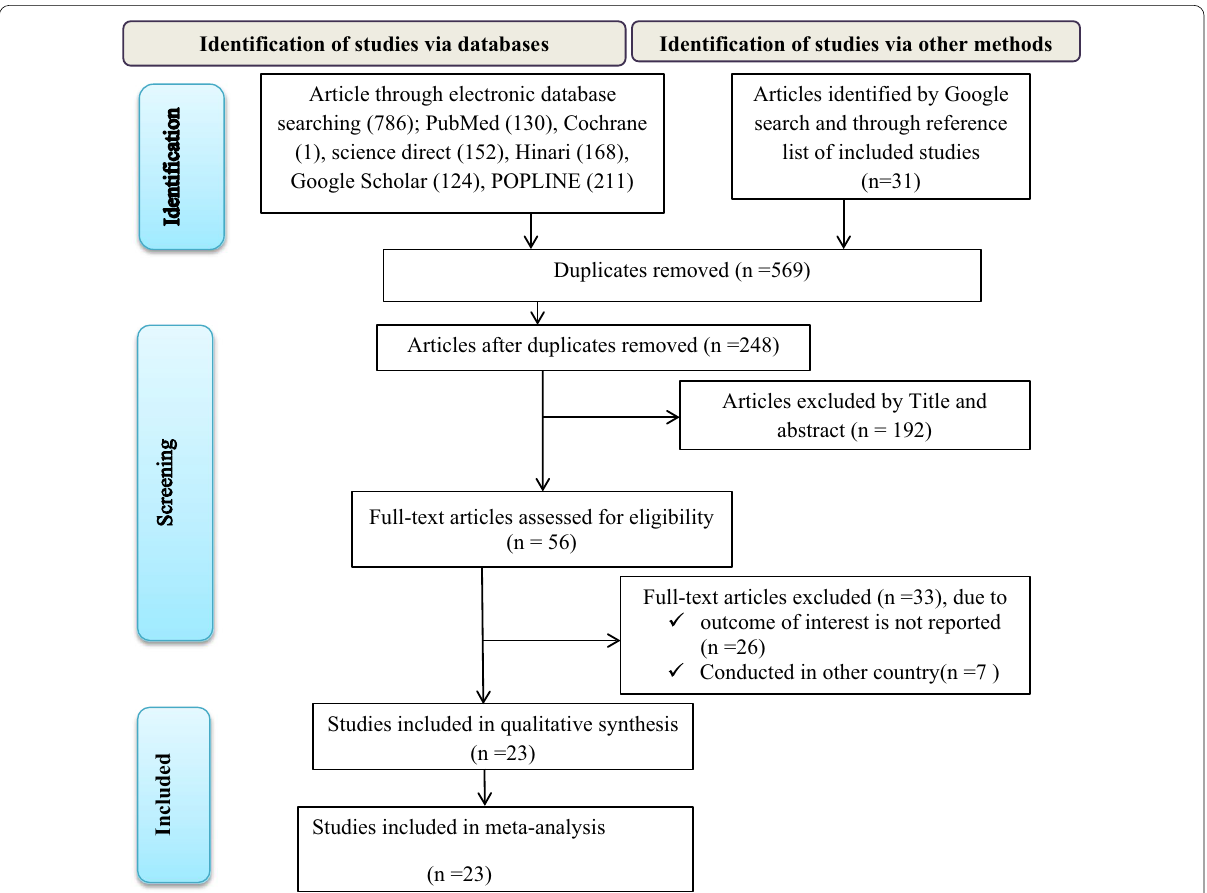
Fig. 1 Flow chart of study selection for systematic review and meta-analysis of food hygiene practice among food handlers in